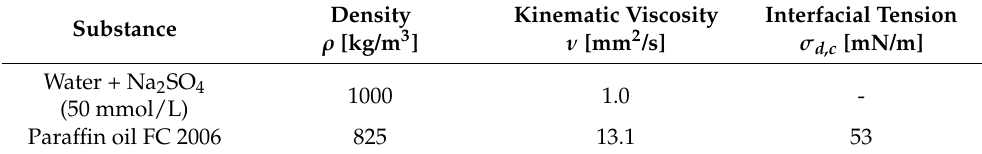
Table 1. Physical properties of the used substances at a temperature of 20 °C. Substance